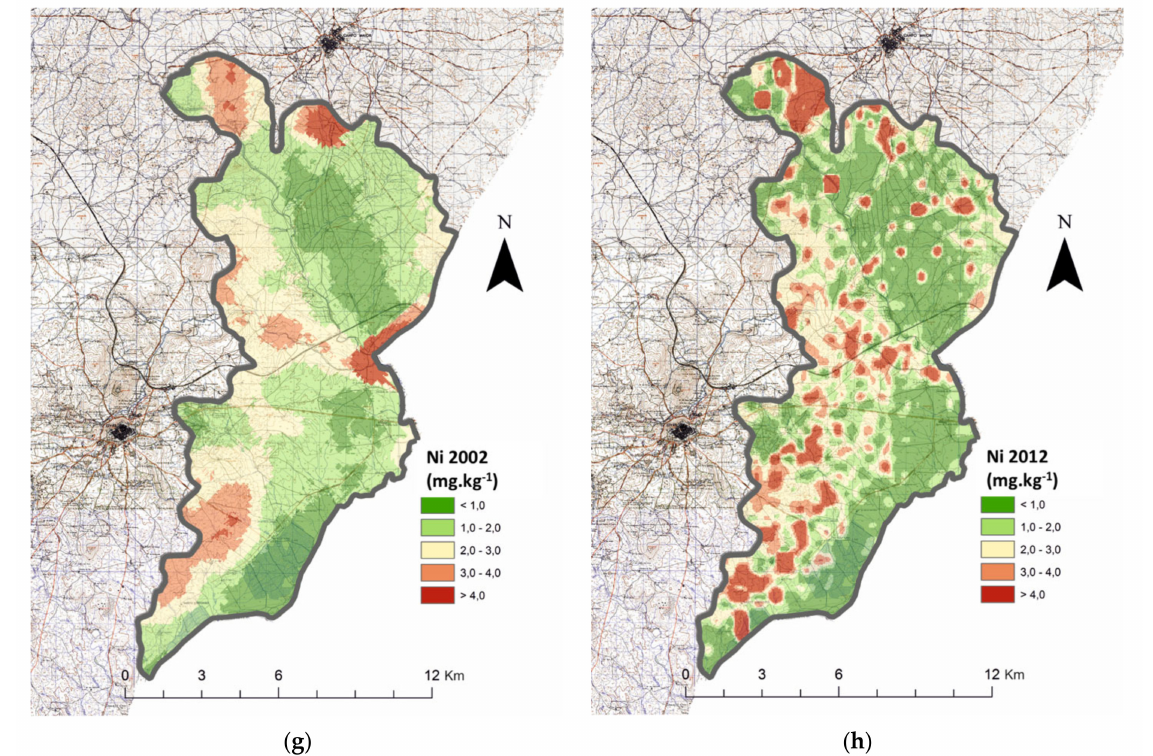
Figure 5. Predictive maps for available ( a ) Cu in 2002, ( b ) Cu in 2012, ( c ) Zn in 2002, ( d ) Zn in 2012, ( e ) Mn in 2002, ( f ) Mn in 2012, ( g ) Ni in 2002, and ( h ) Ni in